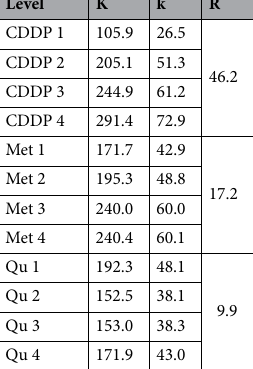
Table 4. Range analysis of L16 (4 3 ) orthogonal test. K represents the data sum of the test index under each factor and level; k represents the average value of the test index under each factor and level; R represents the extreme